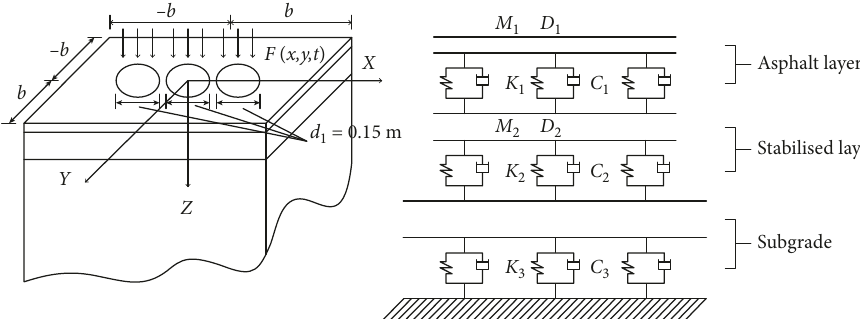
Figure 1: Elastic double-layer plate model on a viscoelastic